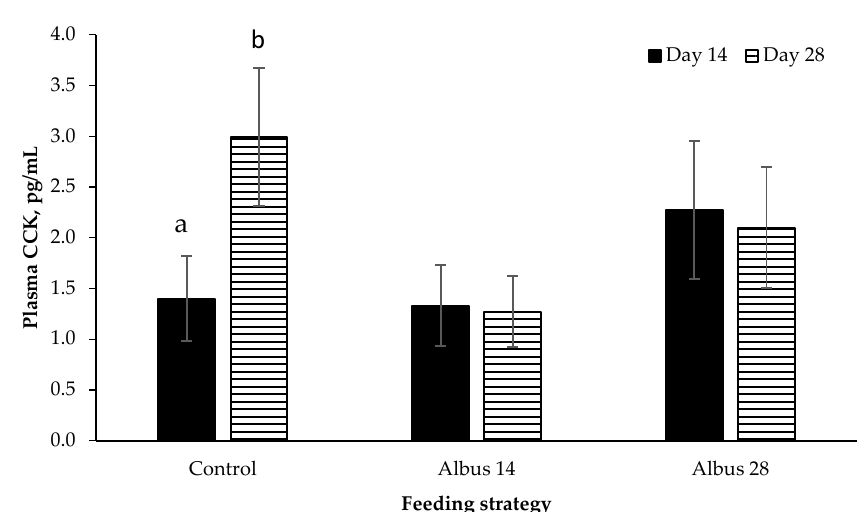
Figure 1. Plasma cholecystokinin (CYY) concentration on day 14 and day 28 after the implementation of the feeding strategy (mean ± SE; n = 24). There was a time × diet interaction ( p = 0.002). Data for entire males and IC males have been pooled as there was no effect of sex or any interactions ( p > 0.05). a,b Different superscripts within diets are significantly different.